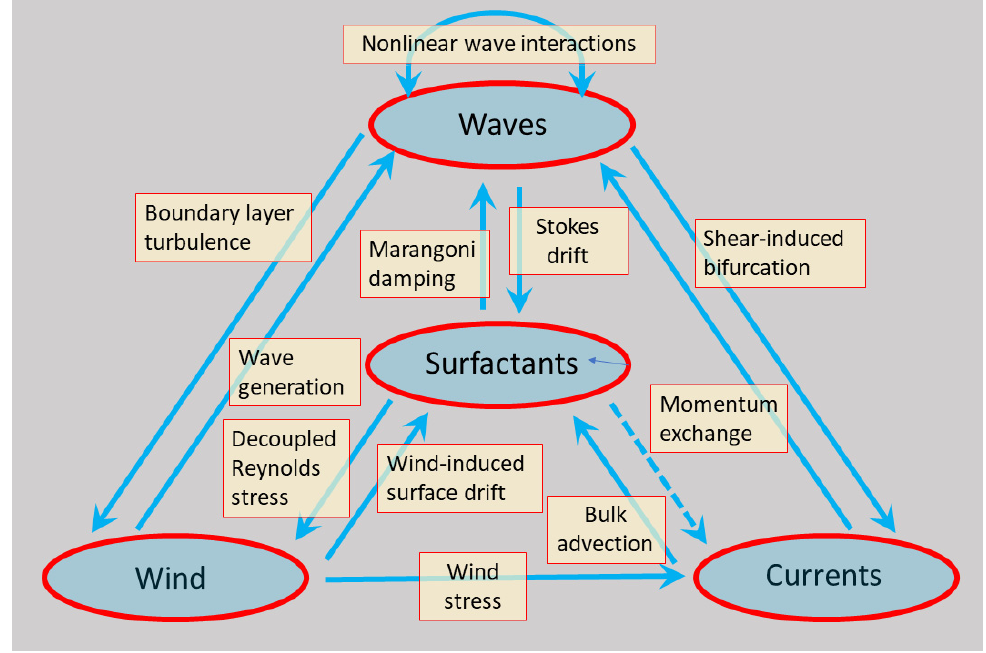
Figure 49. Mechanisms whereby surfactants couple to the main dynamical processes that govern the ocean surface environment .